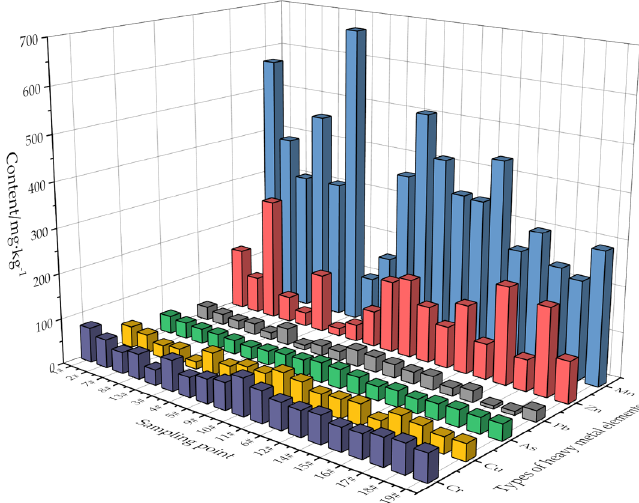
Figure 2. Horizontal distribution characteristics of HMs in